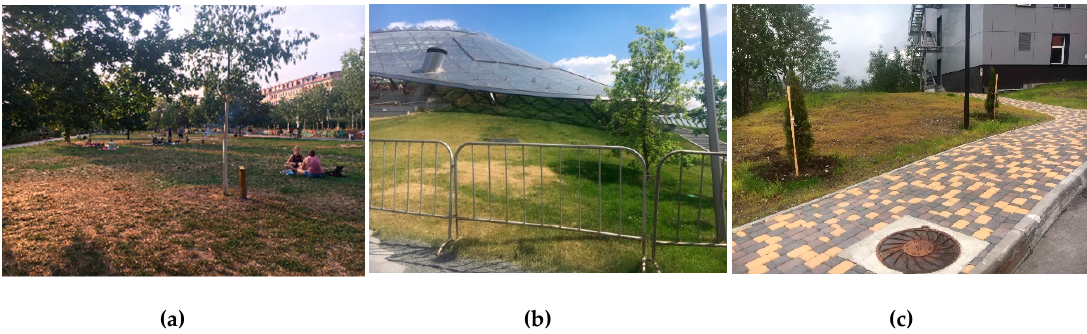
Figure 8. Degradation of lawns from overuse (trampling) and drought. Lawns were established on former post-industrial site ( a ) or wasteland ( c ): ( a ) Lene-Voigt Park, Leipzig (Germany), ( b ) Zaryadye Park, Moscow (Russia), ( c ) public green space near a hospital in Kirovsk, Russia. Photos: D. Dushkova.